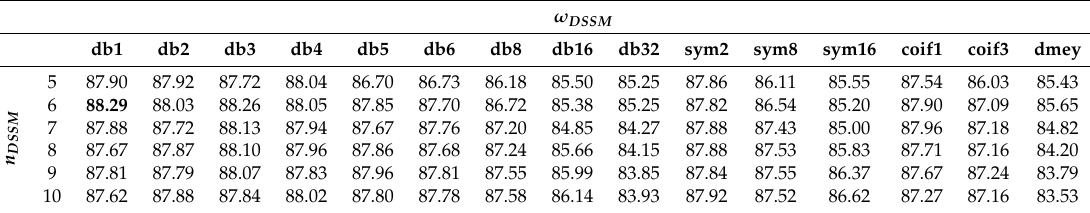
Table 7. The accuracy (%) of three class sleep stage classification with different wavelet bases and different order of DSSM under R&K standard. Only DSSMFs are used, no LEFs.